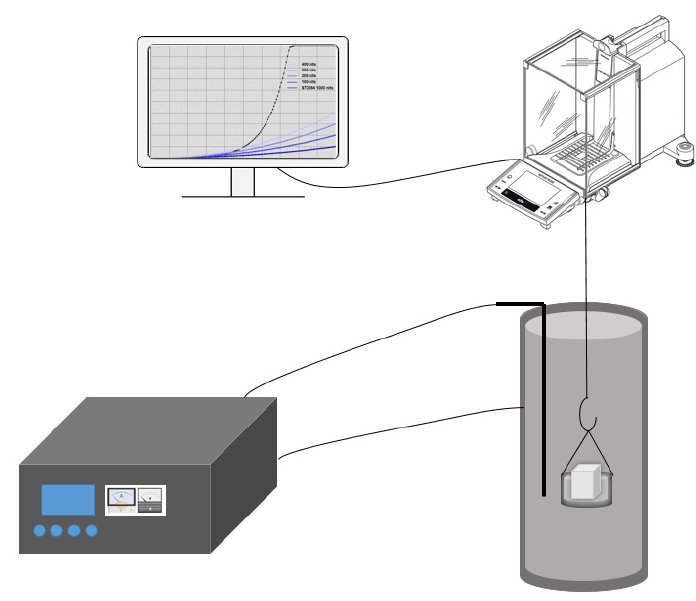
Figure 1. Schematic diagram of high-temperature oxidation unit.